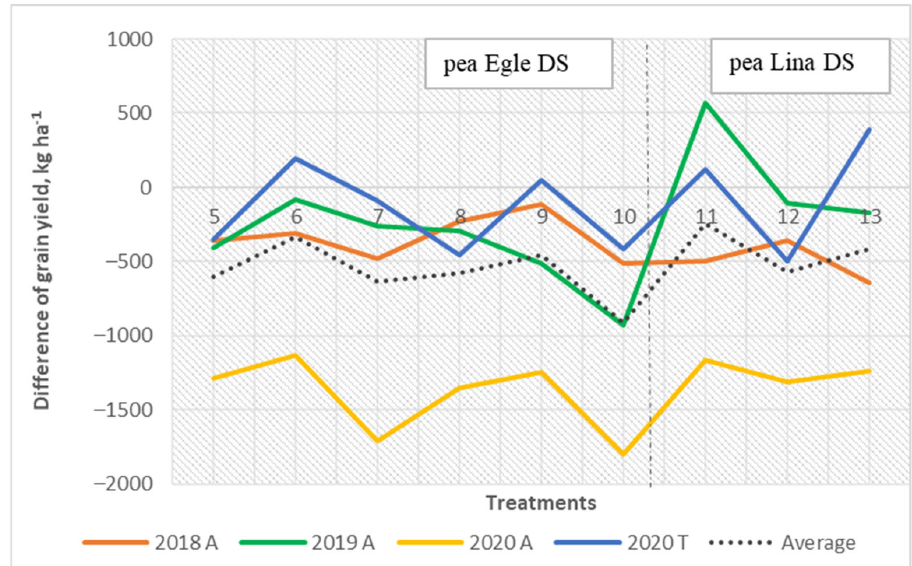
Figure 5. The grain yield of pea in the mixed cropping: difference between actual and expected grain yield.